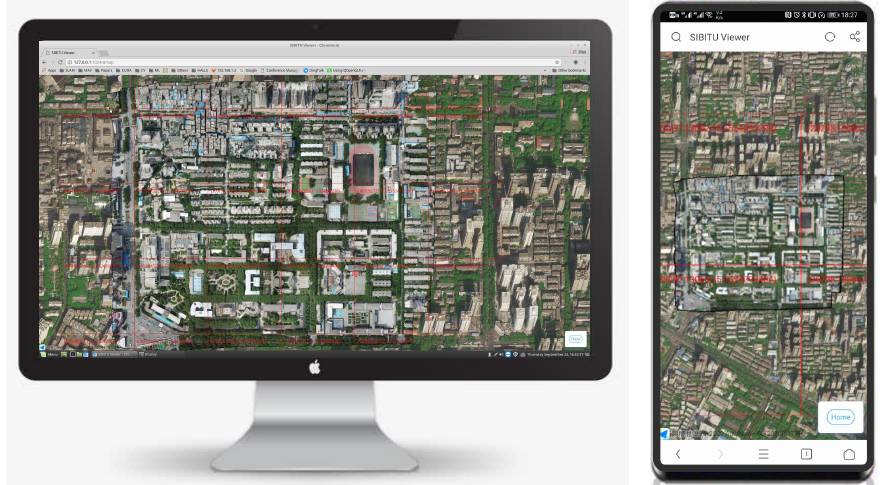
Figure 7. The live map can be visualized in PC and mobile phone web browsers. To share the dynamic orthophoto through network efficiently, a restful API, and a corresponding rendering strategy is designed. Only tiles, which are visible and updated, are transferred, and a network with over 100 KB/s bandwidth is sufficient to render a low-latency high-resolution dynamic layer. This finding indicates that the real-time mapping service can be placed everywhere and shared through the